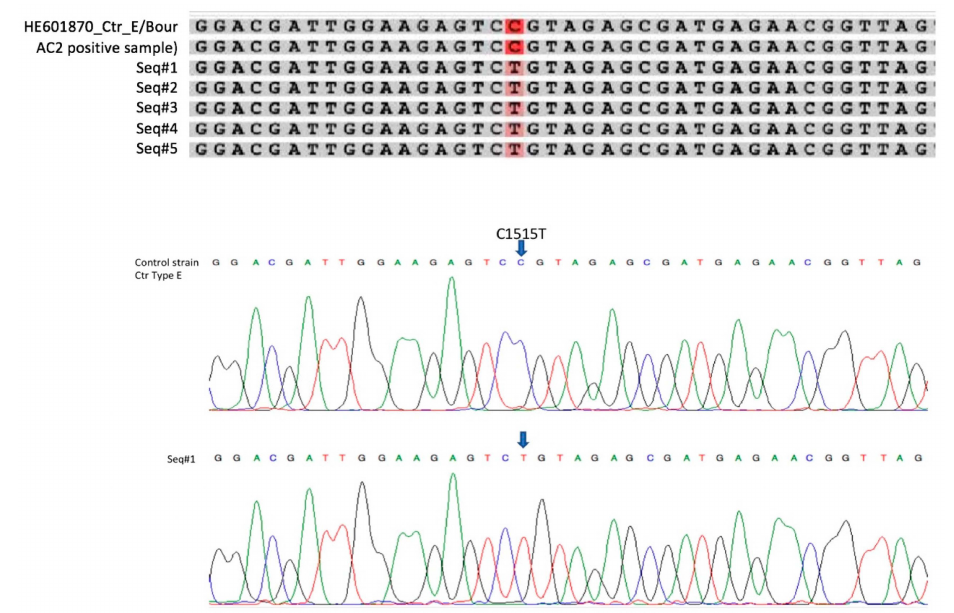
Figure 5. The single mutation C1515T in 23S rRNA gene of Chlamydia trachomatis . Alignment of sequences of samples 1–5 (Table 2), an Aptima Combo 2 positive sample and a reference strain, and chromatograms of control strain genotype E and sample 1 showing the